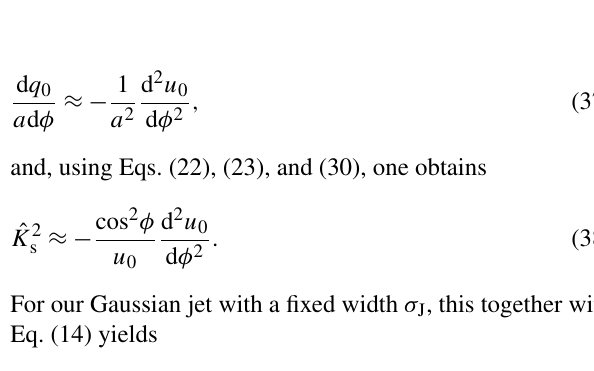
Figure 7. Zonal Fourier spectrum of v averaged over 30–60 ◦ N, for (a) solid-body rotation, (b) a weak narrow jet with U J = 10ms − 1 , and (c) a strong narrow jet with U J = 40ms − 1